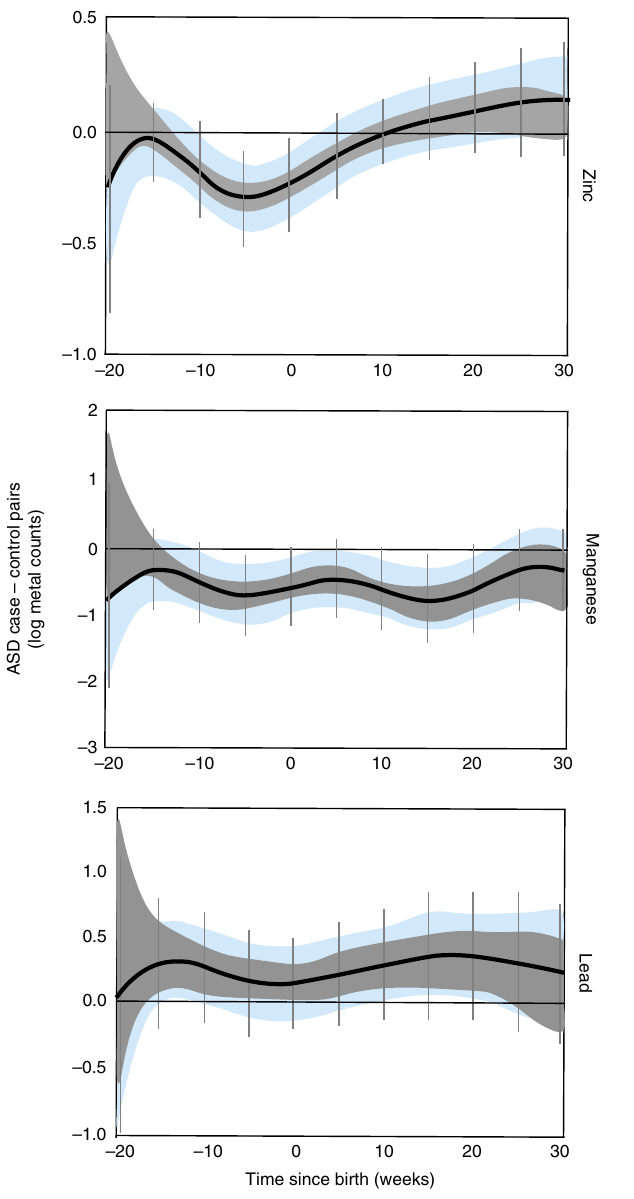
Figure 5 | Developmental periods of maximal metal dysregulation in ASD discordant versus ASD concordant twin pairs. DLMs for zinc, manganese and lead. Black line represents mean of paired differences in metal levels between twins discordant for ASD (3 MZ; 4 DZ) and ASD concordant pairs (5 MZ; 1 DZ). Data are shown as 95% bands unadjusted (grey band) and adjusted (blue band) for intra-twin correlations. Grey vertical lines are Holm–Bonferroni corrected family-wise 95% CIs for 11 comparisons (every fifth week). Values above zero represent increased levels in ASD cases compared to their non-ASD twins after taking into account average difference in concordant twins. A critical window is defined as an area of the DLM adjusted for intra-twin correlations (blue band) that does not include zero. Models were adjusted for sex, zygosity, gestational age, the average birth weight of the twin pairs, and the s.d. of the birth weight in the twin pairs.